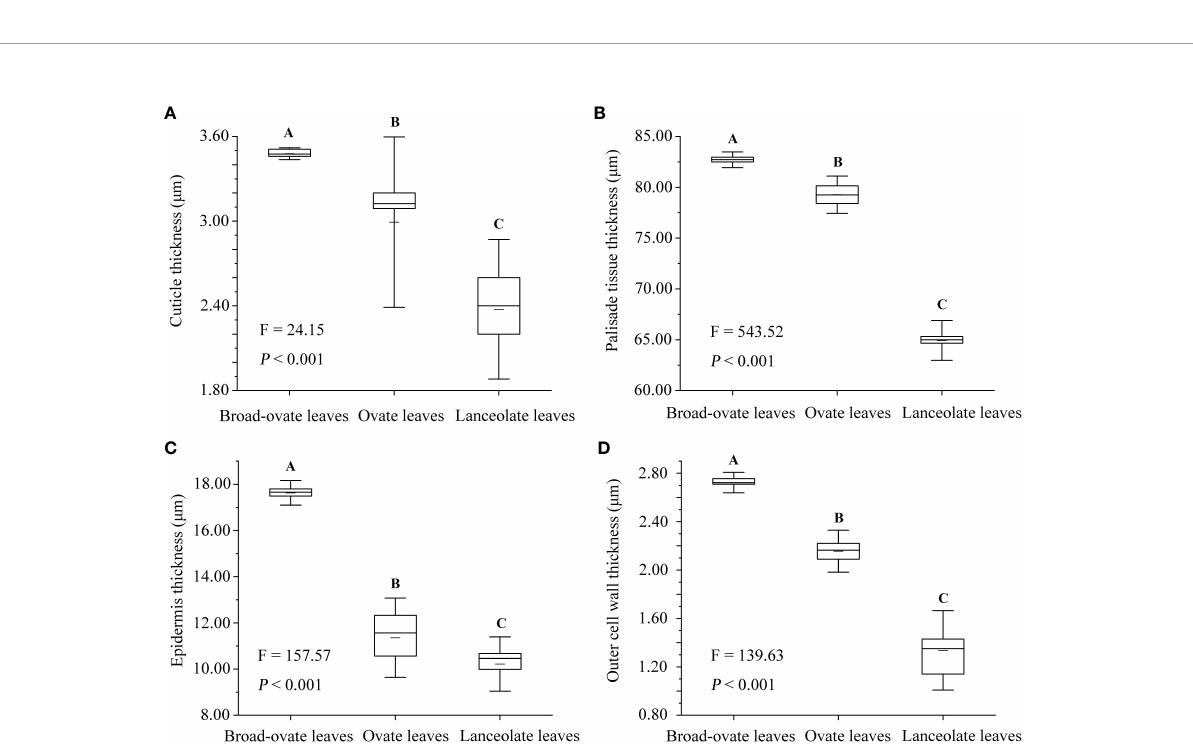
FIGURE 3 Differences in anatomical structures among the three types of heteromorphic leaves. The instructions of P , F , and other capital letters are shown in Figure